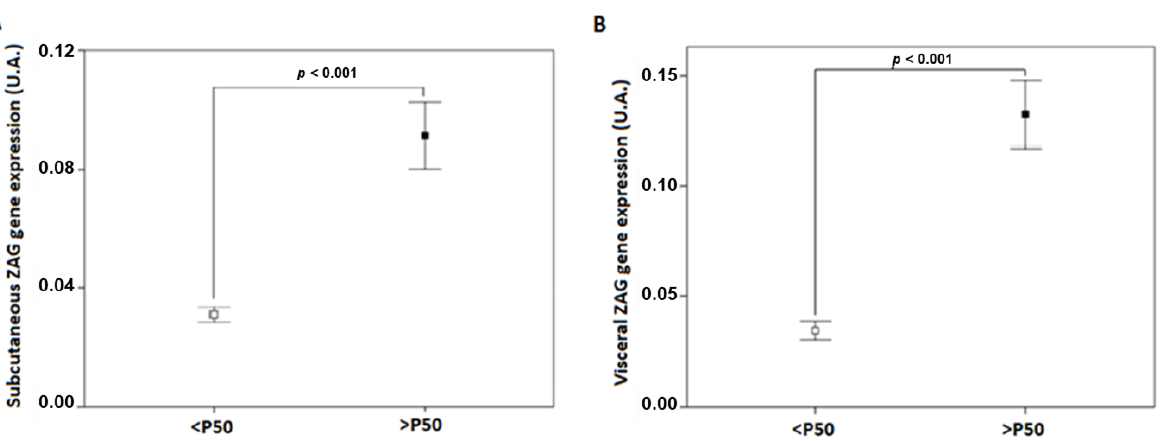
Figure 1. ZAG gene expression levels in SAT ( A ) and VAT ( B ) adipose tissue of patients with class III obesity. P50, the 50th percentile of ZAG; SAT, subcutaneous adipose tissue; VAT, visceral adipose tissue; ZAG, zinc- α 2 glycoprotein. Table 1. Clinical and biochemical characteristics of studied patients with class III obesity before bariatric surgery (basal) classified by the 50th percentile of SAT and VAT ZAG gene expression.